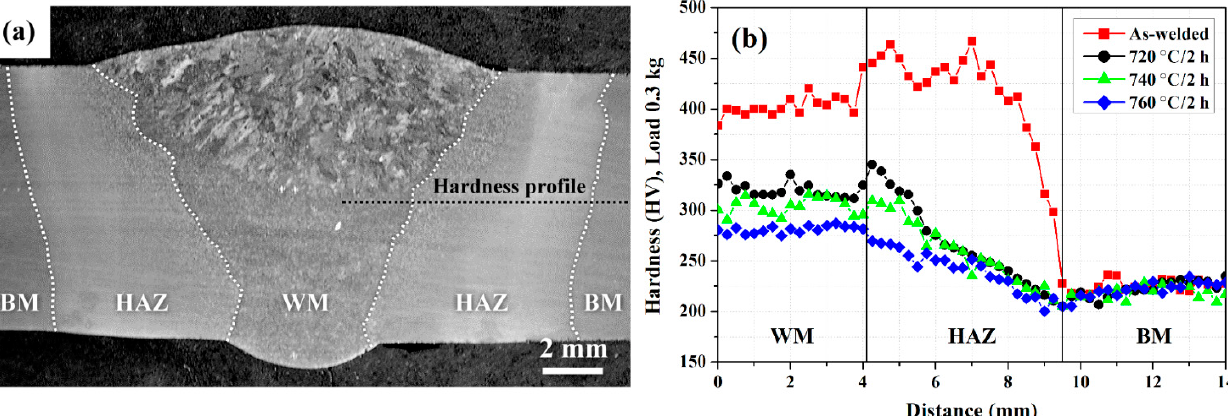
Figure 2. ( a ) Macroscopic appearance of a T92 weld in cross-sectional view cut from the butt-welded tube, ( b ) microhardness curves of the welds determined from the centerline of the WM across the heat-affected zone (HAZ) to the base metal (BM) in the as ‐ welded and tempered conditions.